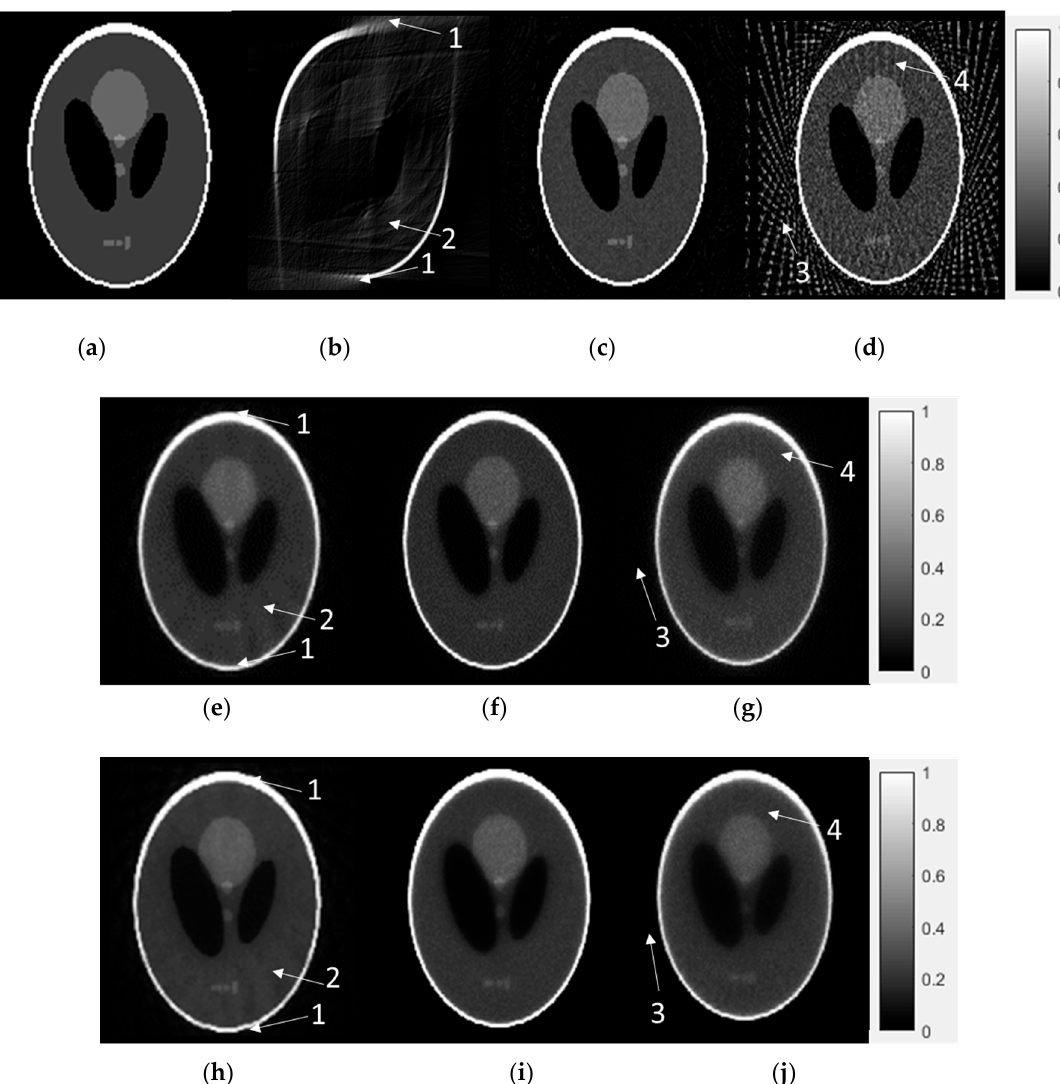
Figure 7. Numerical results for 3D Shepp-Logan phantom: ( a ) True image. ( b ) FDK with LA mode (1 ◦ /projection with 90 ◦ coverage), ( c ) FDK with DSFC (1 ◦ /projection with 360 ◦ coverage) mode, ( d ) FDK with LSFC (5 ◦ /projection with 360 ◦ coverage) mode. ( e ) ASD-POCS + CE inpainting + IQ-based stopping criteria for LA mode, ( f ) DSFC and ( g ) LSFC mode. ( h ) EM-TV-based algorithm + CE inpainting + IQ-based stopping criteria for LA, ( i ) DSFC and ( j ) LSFC mode. Arrows point to the four types of artifact patterns: (1) unsmoothed shape edge (2) curved-ripple pattern (3) streak-artifact and (4) radiative-pattern.